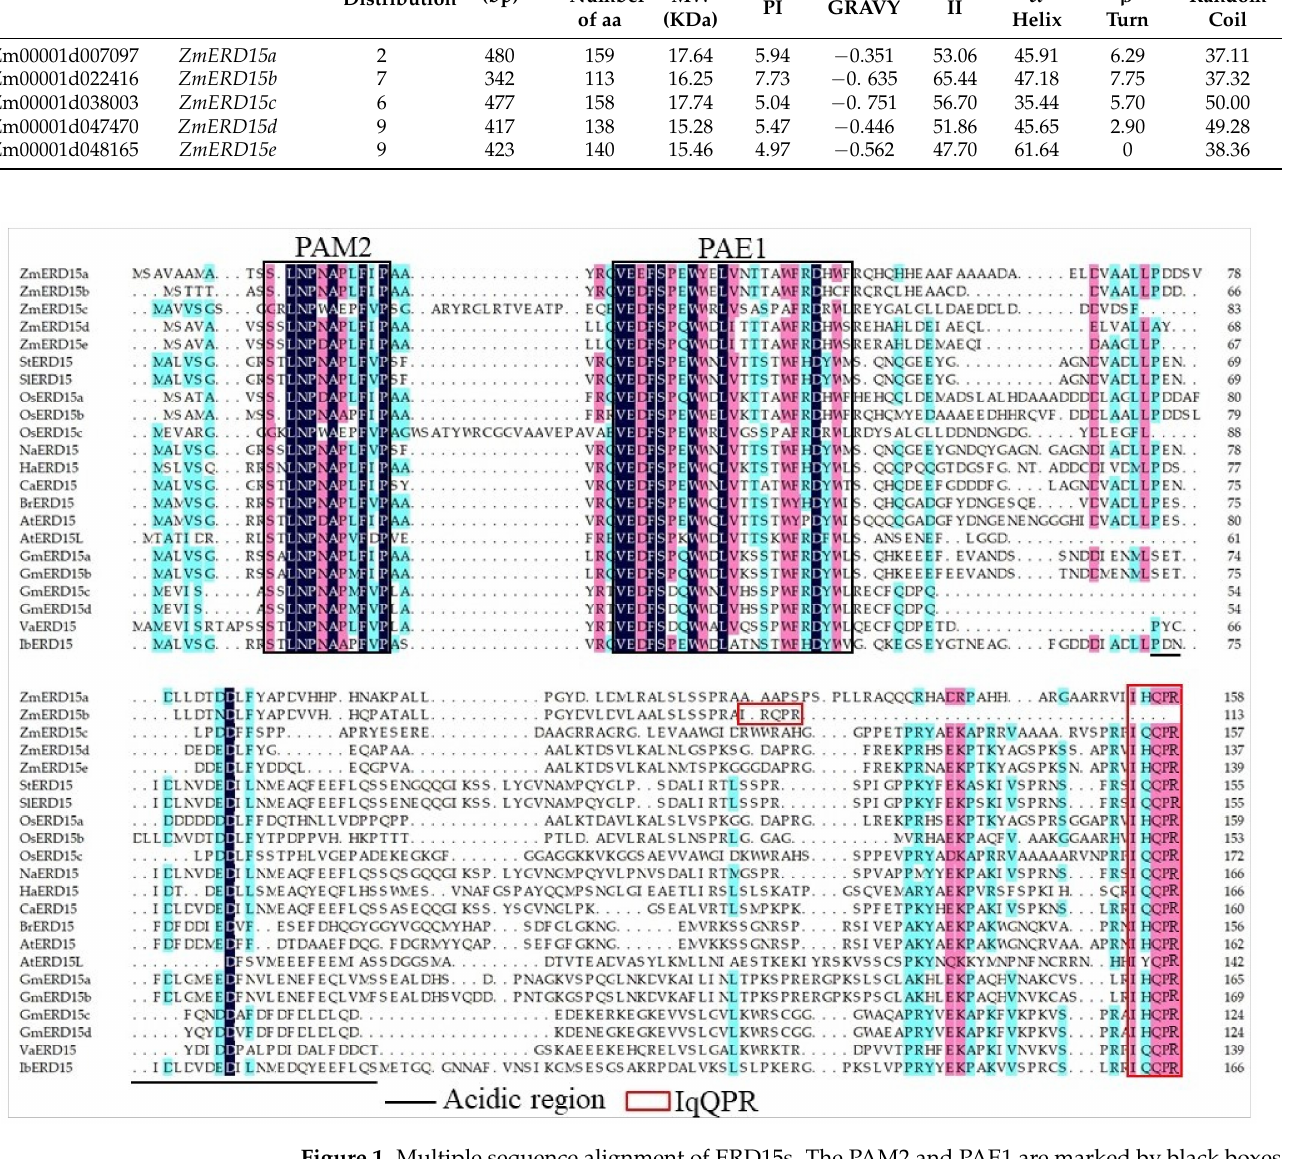
Figure 1. Multiple sequence alignment of ERD15s. The PAM2 and PAE1 are marked by black boxes. The acidic region and IqQPR sequence are marked with black underlining and a red box, respectively. The mazarine, pink, and light-blue backgrounds indicate perfect (100%), high (75%), and low (50%) conservation,